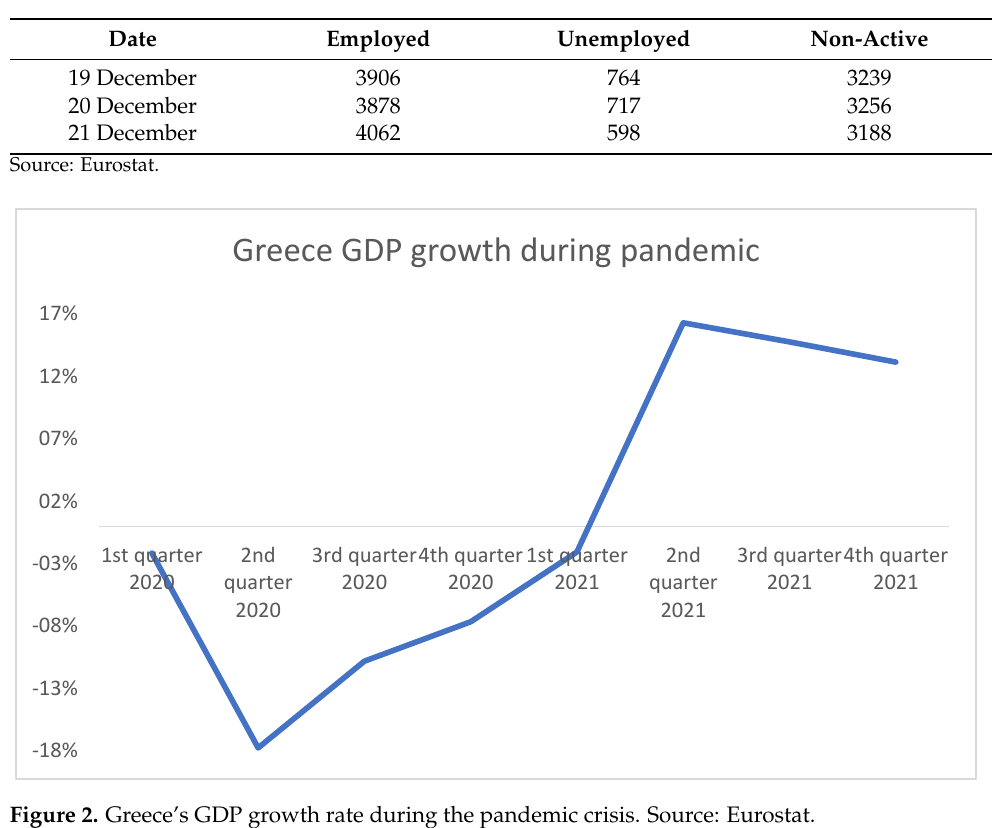
Table 1. Greece’s unemployment indexes (in thousands) .